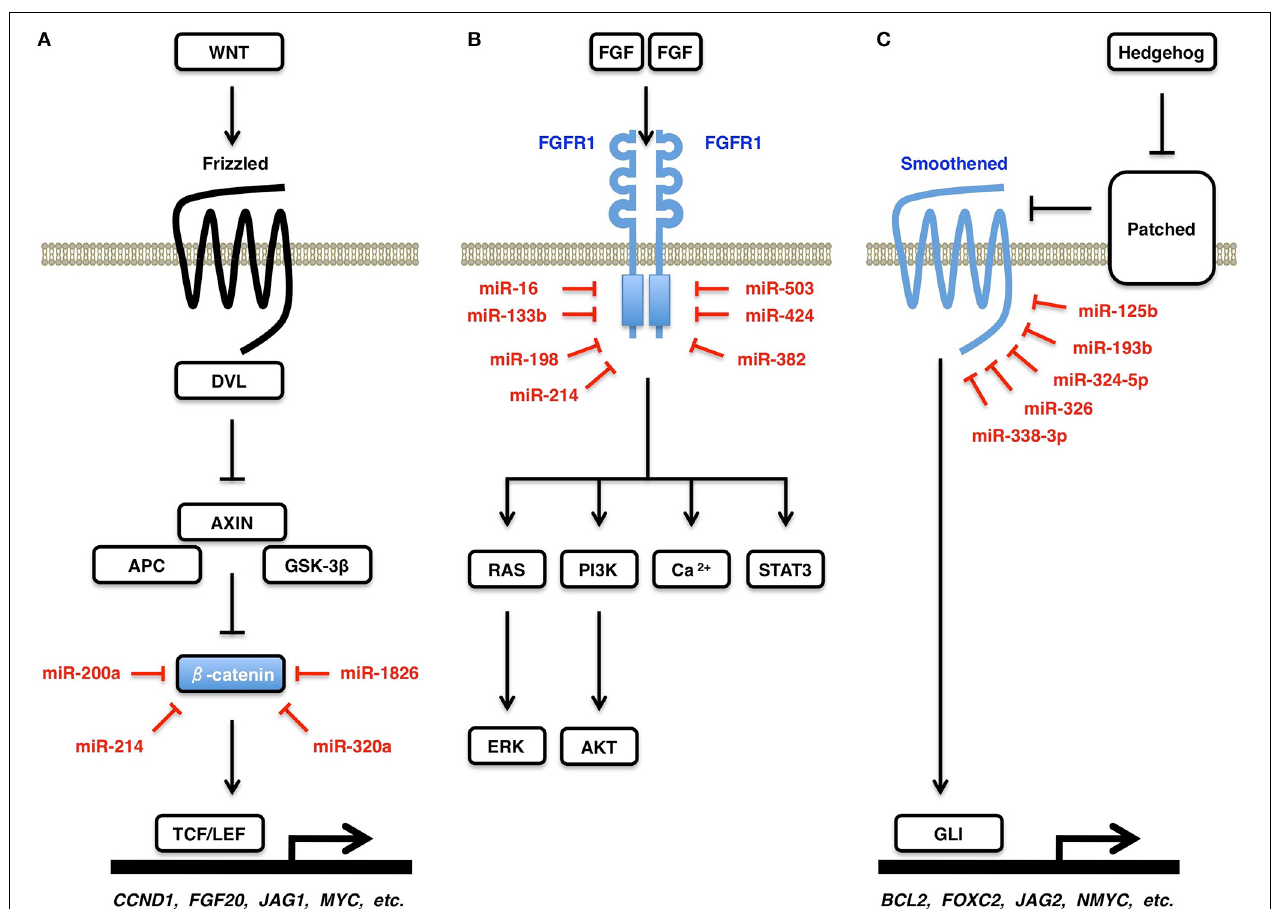
FIGURE 4 | WNT, FGF, and Hedgehog signaling cascades. (A) Canonical WNT signaling cascade and β -catenin. Canonical WNT signaling activation releases β -catenin from its degradation complex of APC and AXIN, which results in nuclear translocation of β -catenin and transcriptional activation of TCF/LEF-target genes, such as CCND1 (Cyclin D1) , FGF20 , JAG1, and MYC (c-Myc) . β -catenin is a direct target of miR-200a, miR-214, miR-320a, and miR-1826. (B) FGF signaling cascades and FGFR1. FGF signals induce dimerization and auto-phosphorylation of a receptor